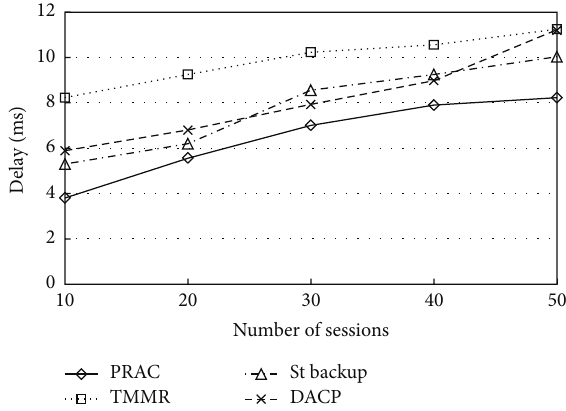
Figure 4: Throughput.